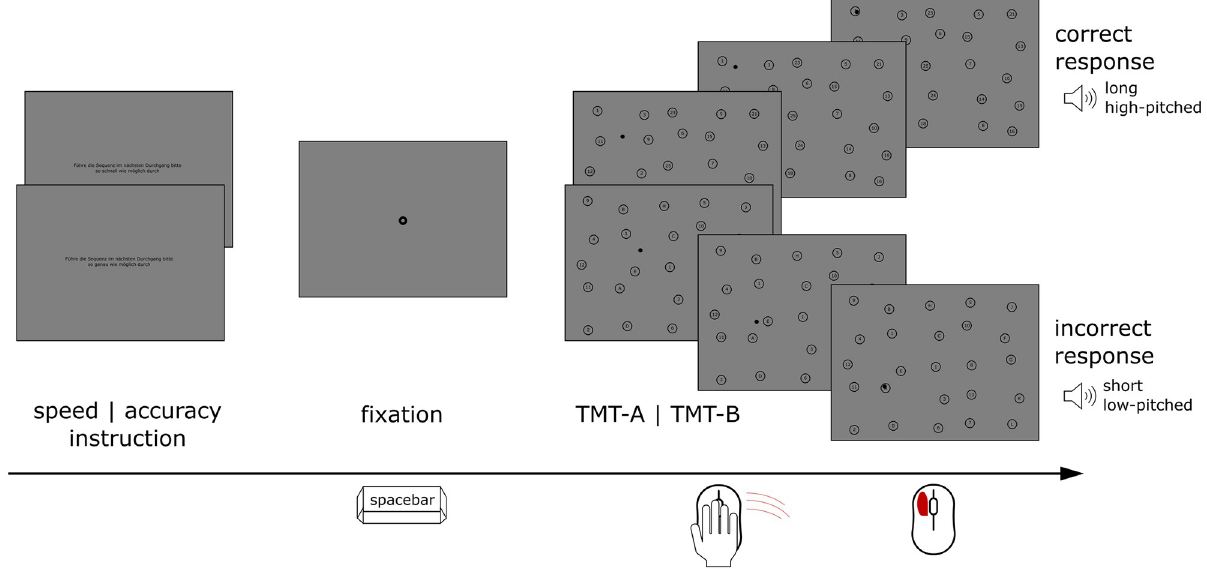
Fig 1. Trial procedure. Time course of a trial in this version of the TMT. Participants were first instructed to hit targets in the following trial either as fast (speed) or as central (accuracy) as possible. After a fixation display, they started the TMT sequence by pressing the space bar. Participants clicked the sequence of numbers (TMT-A) or numbers and letters (TMT-B) in ascending order while their eye movements were recorded. Correct answers were indicated by a high-pitched sound, wrong answers were indicated by a low-pitched sound. The black dot indicates the current position of the